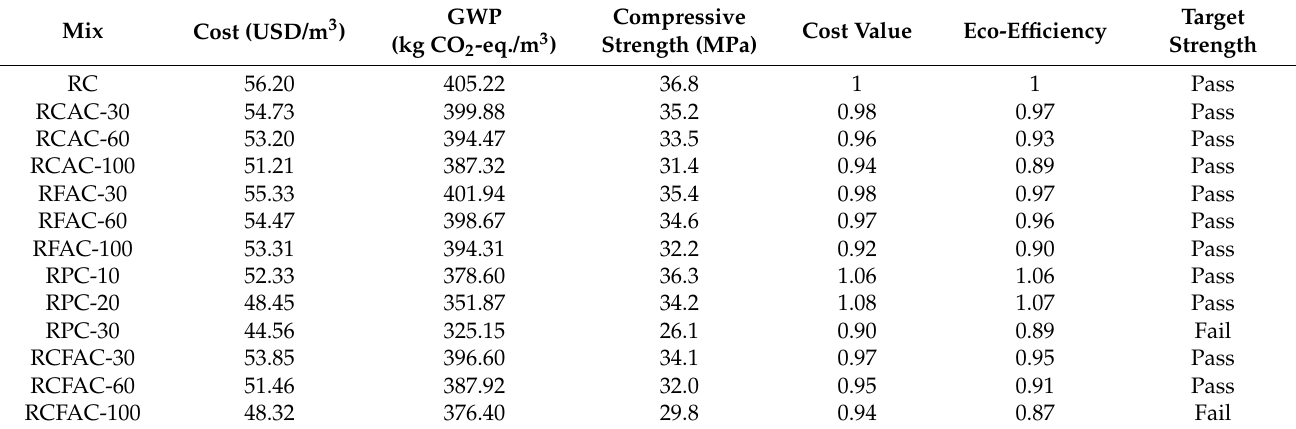
Table 7. Cost and environmental analysis of various